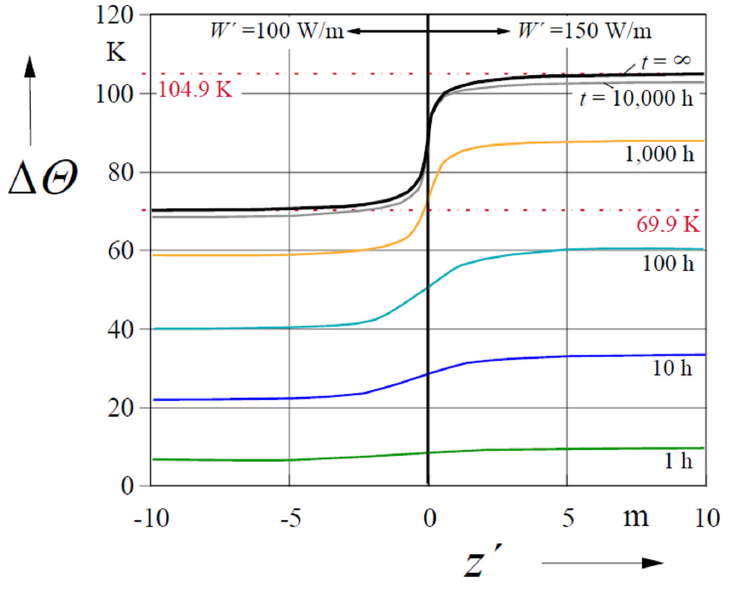
Figure 8. Thermal response at a point with Δ y = 0.05 m to a finite line of point sources with loss steps of 100 W/m and 150 W/m, as defined in Figure 7.